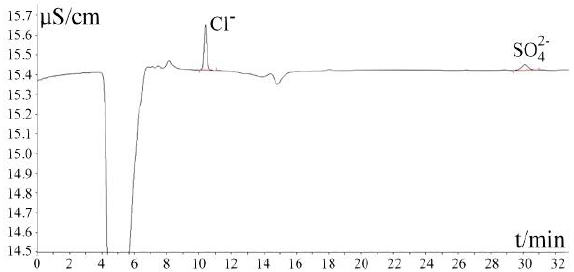
Figure 5. Chromatogram of a real